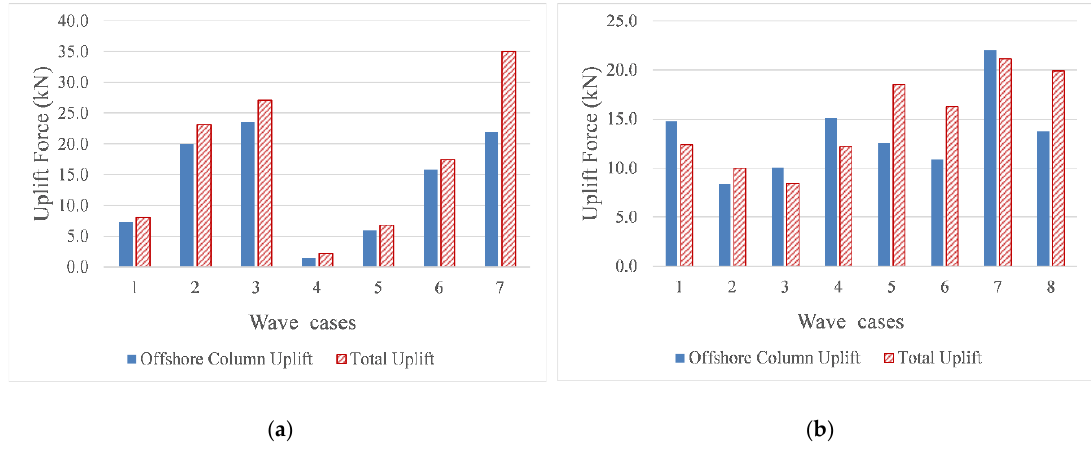
Figure 10. Maximum uplift forces measured in the offshore column-bent cap connections versus the maximum total uplift for solitary waves ( a ) and bores ( b ).